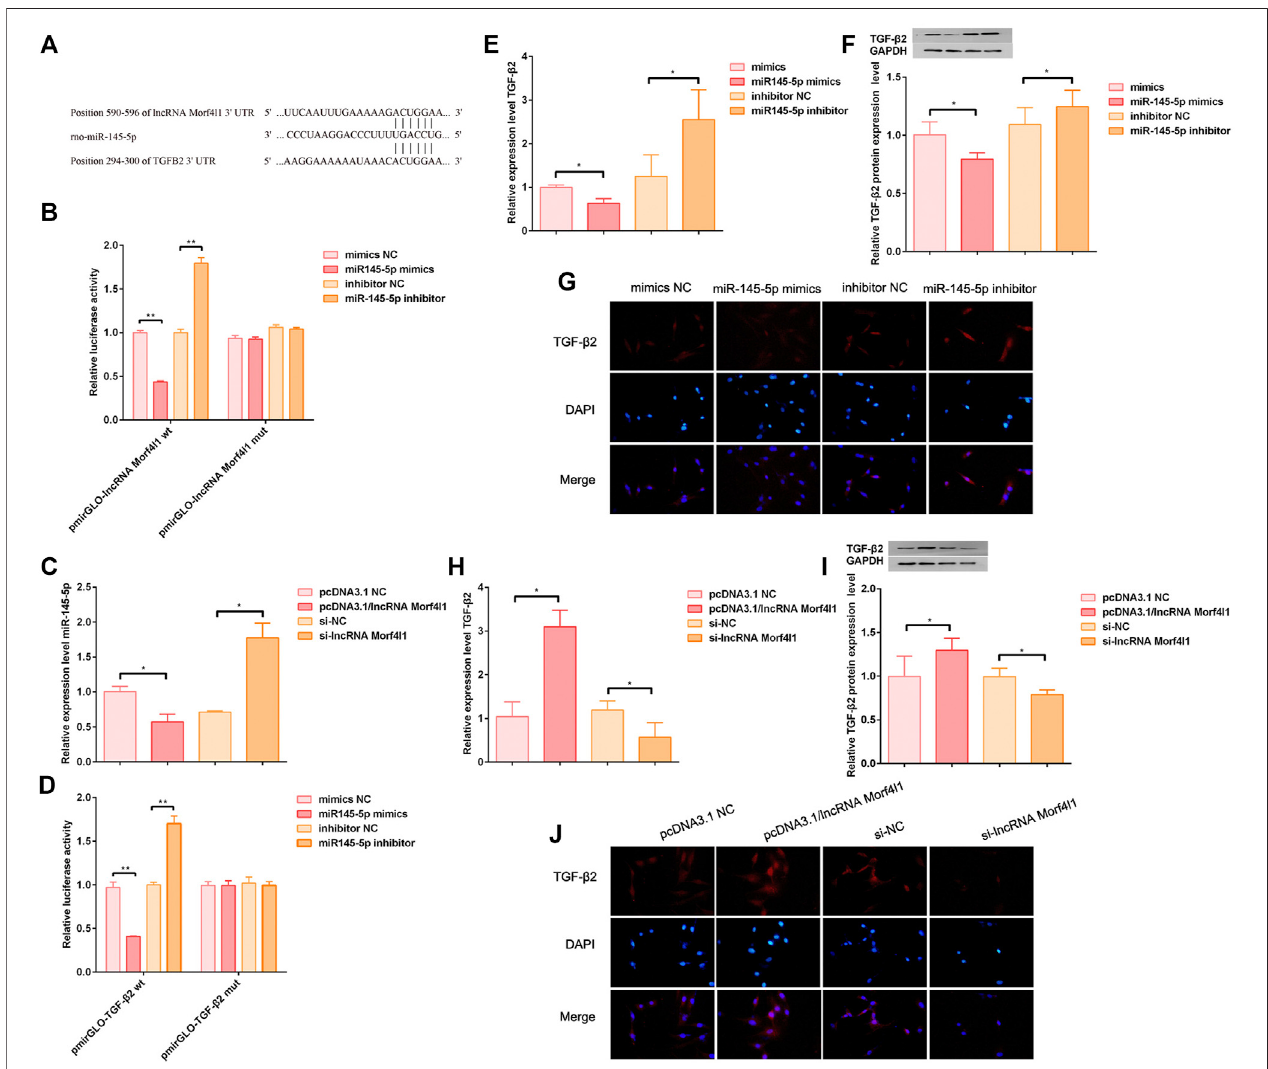
FIGURE3 | LncRNA Morf4l1 promoted the expression of TGF- β 2throughtargeting3 ′ U ofmiR-145-5p. (A) Targetscan wasperformed topredict putative binding sites (B) LuciferasereporteranalysiswasusedtodetectthebindingsbetweenlncRNAMorf4l1andmiR-145-5pin293Tcell.OverexpressionorinhibitionofmiR-145-5p in the lncRNA Morf4l1 wild type (wt) enhanced or weakened the luciferase activity, while the lncRNA Morf4l1 mutant type (mut) did not change (C) The effect of lncRNA Morf4l1 intervention onthe expression ofmiR-145-5pintenocyteswasevaluated usingqRT-PCR (D) Luciferase reporter analysiswasusedtodetect thebindings between miR-145-5p and TGF- β 2 in 293T cell. Overexpression or inhibition of miR-145-5p in the TGF- β 2 wild type (wt) enhanced or weakened the luciferase activity, whiletheTGF- β 2mutanttype(mut)didnotchange (E) TheeffectofmiR-145-5pinterventionontheexpressionofTGF- β 2intenocyteswasevaluatedusingqRT-PCR (F) TheeffectofmiR-145-5p interventionontheexpressionofTGF- β 2intenocyteswasevaluatedusingWesternblot (G) Theresultsofimmuno fl uorescenceassayshowed thatmiR-145-5pwasoverexpressedorinhibited,affectingtheexpressionofTGF- β 2.DAPIwasperformedtostainnuclei(blue);theabovered fl uorescenceintensitywas positively correlated with the expression of TGF- β 2; Under the merged image; Base magni fi cation:×200 (H) The effect of lncRNA Morf4l1 intervention on the expression of TGF- β 2 in tenocytes was evaluated using qRT-PCR (I) The effect of lncRNA Morf4l1 intervention on the expression of TGF- β 2 in tenocytes was evaluated using Western blot (J) Immuno fl uorescence assay results showed that lncRNA Morf4l1 was overexpressed, thus promoting the expression of TGF- β 2, and vice versa; Base magni fi cation:×200 ( n = 3; Mean ± SD, * p < 0.05, ** p < 0.01, *** p < 0.001; Student ’ s t-tests).